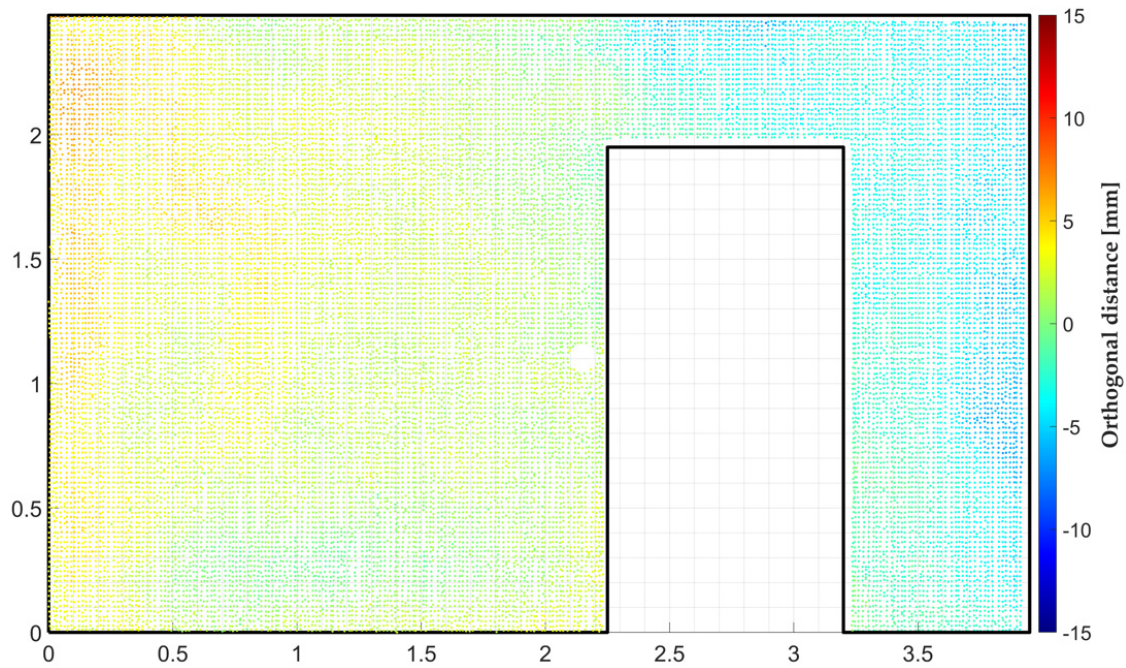
Figure 6. Comparison of the segmented as-built point cloud with the BIM